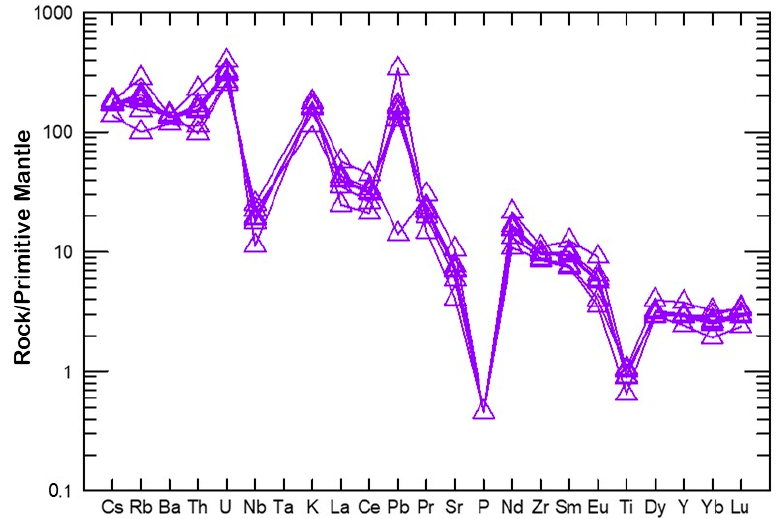
Figure 14. Primitive mantle-normalized trace element patterns of the felsite dike [46].